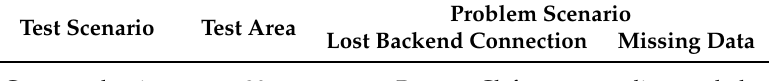
Table 3. Evaluation matrix showing the problem scenarios: Lost Backend Connection Scenario (LBCS) and Missing Data Scenario (MDS); test scenarios: Cross-Evaluation Test Scenario (CTS) and Application Test Scenario (ATS); strategies: Regression (Regr) and Classification